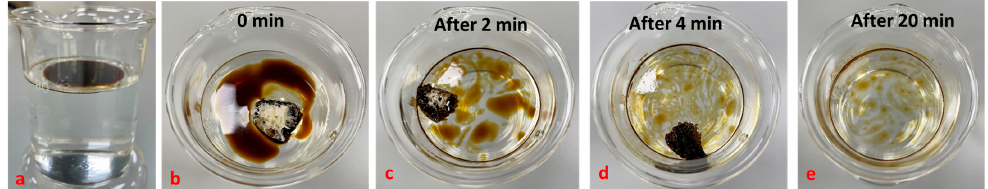
Table 4. Calculation of water absorption percentage to understand hydrophobicity of the unmodi- fied and modified PU foam. Polymer